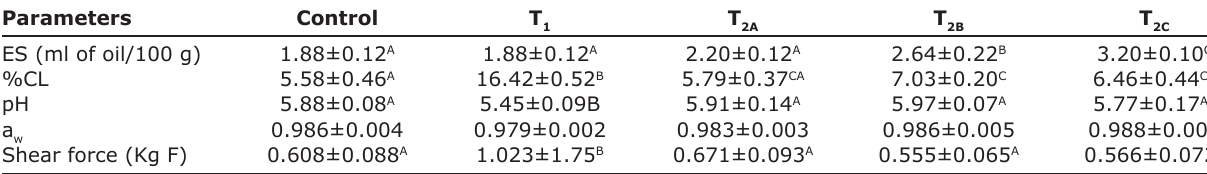
, and shear force values (mean±SE) of pork sausages. w